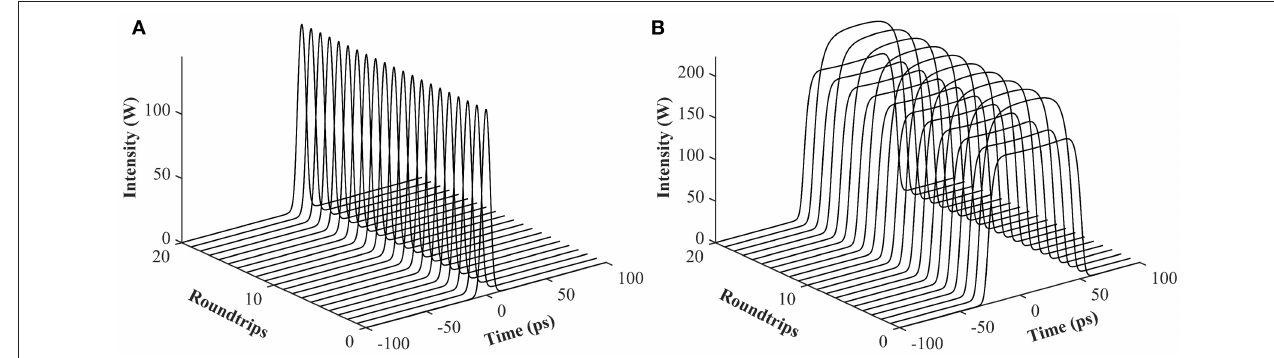
FIGURE 2 | The evolution of output pulses with cavity roundtrips. (A) Three-dimension evolution at a pump E sat of 1 nJ. (B) Three-dimension evolution at a pump E sat of 10 nJ.